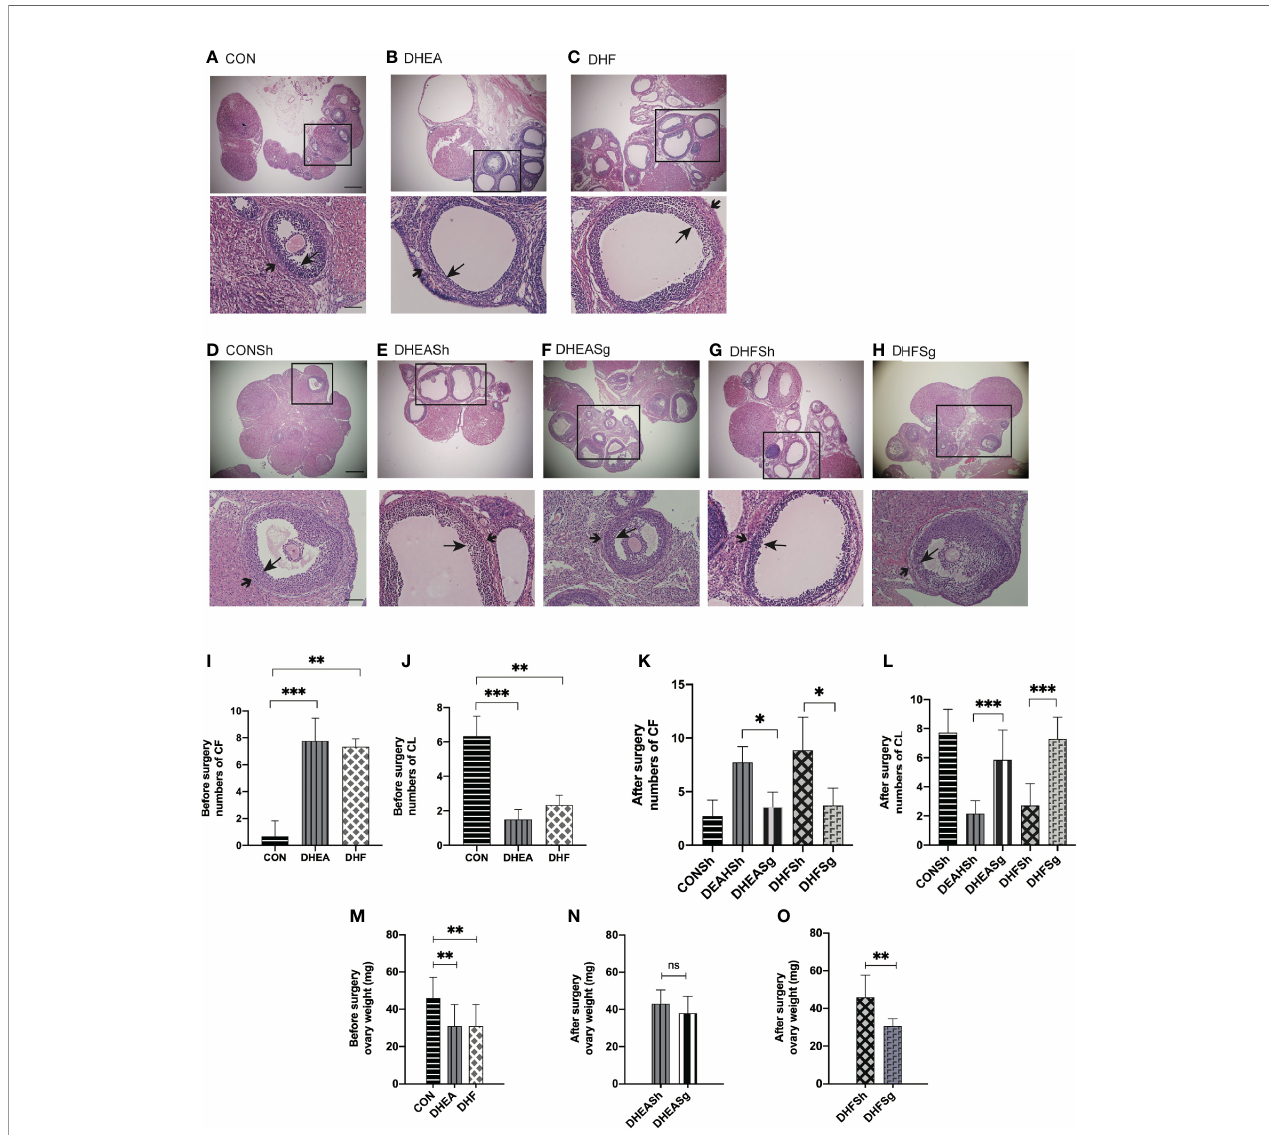
FIGURE 4 | Effects of sleeve gastrectomy (SG) on ovarian morphology, as observed in hematoxylin and eosin-stained tissue sections. (A, B) Representative images of ovarian tissues from CON (A) , DHEA (B) , and DHF (C) rats pre-surgery. (D – H) Representative images of ovarian tissues from CONSh (D) , DHEASh (E) , DHEASg (F) , DHFSh (G) , and DHFSg (H) rats post-surgery. From (A – H) : Scale bar, 100 m m; original magni fi cation for a, b, and c: ×4, ×10, and ×20, respectively. The short arrows indicate the theca, and the long arrows indicate the granulosa layer. (I, J) The number of CF (I) and CL (J) before SG. (K, L) The number of CF (K) and CL (L) after SG. CF, cystic follicle; CL, corpus luteum. (M) Ovary weight before surgery. (N) Ovary weight after surgery in the DHEASh and DHEASg groups. (O) Ovary weight after surgery in the DHFSh and DHFSg groups. *p < 0.05. **p < 0.01. ***p <